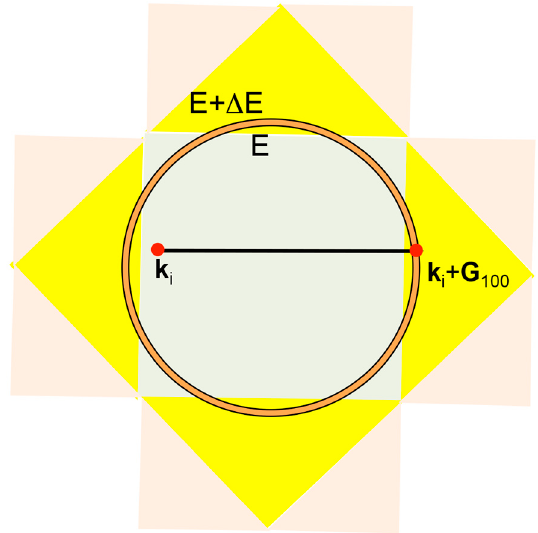
Figure 17. Cross-section of the Fermi surface-Brillouin zone interactions in the extended zone scheme for simple cubic lattice. Some parts of the Fermi sphere enter into the second zone in yellow color but the rest remains in the first zone in grey color. The circular shell sandwiched by double circles represents the cross section of two constant energy surfaces with E and E + Δ E . The electronic state of wave vector k i in the first zone is transferred to its equivalent state k i + G 100 in the second zone with the assistance of the reciprocal lattice vector G 100 . Note that multiple energies including E are assigned in the state k i in the framework of the reduced zone scheme, but the energy E is solely assigned to the state k i + G 100 in the second zone in the framework of the extended zone